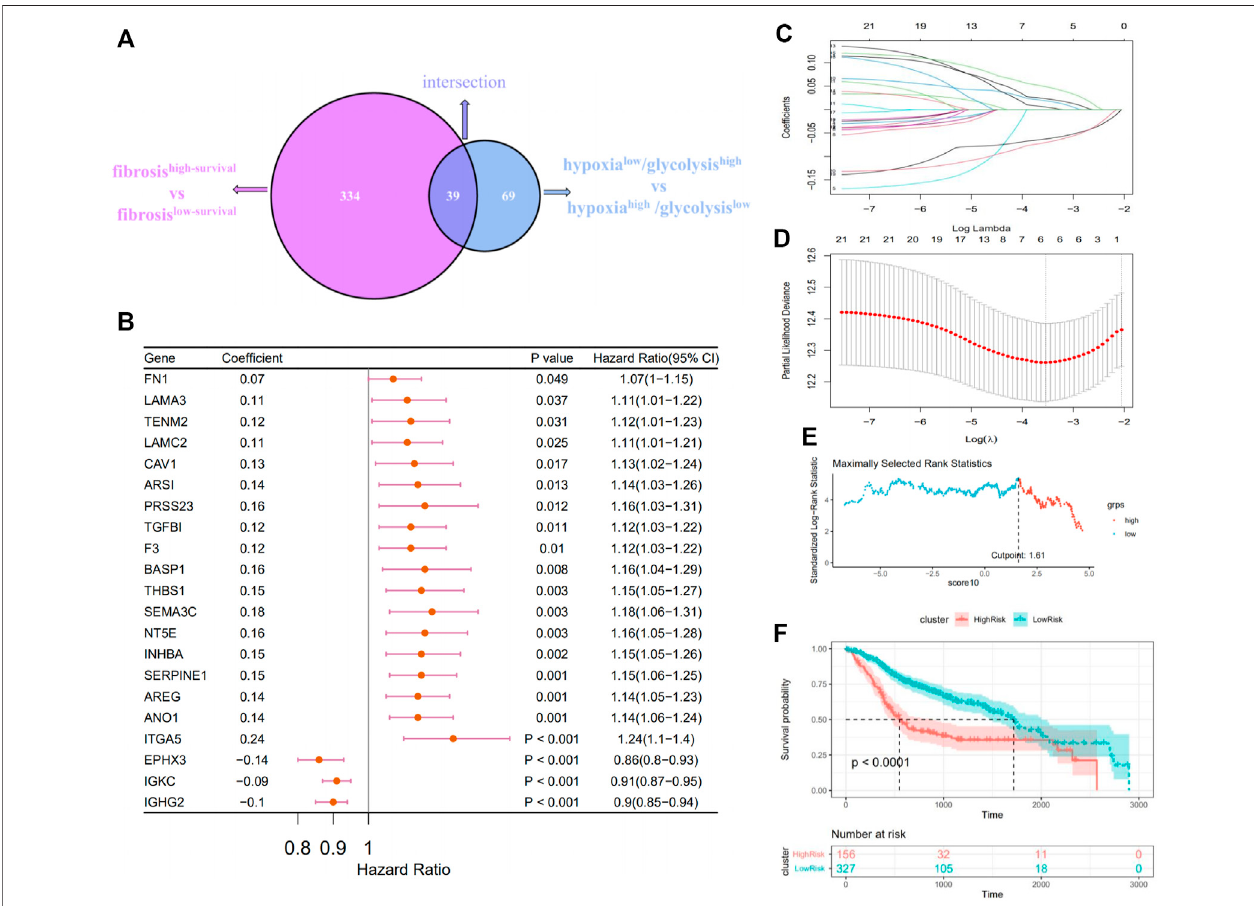
FIGURE 4 | Constructing a prognostic survival model in patients with HNSCC. (A) Venn diagrams show the fi brosis – hypoxia – glycolysis related DEGs (39). (B) Forest plot of the prognostic effects of 21 DEGs with p < .05 on a univariate Cox regression analysis. (C) LASSO coef fi cient pro fi les of 21 screened DEGs. (D) Threefold cross-validation for LASSO analysis was performed to calculate the minimum criteria. (E) A vertical dashed line was used to mark the cutoff point with the maximum standard log-rank statistic. (F) Kaplan – Meier plot established the survival differences between high- and low-risk groups.